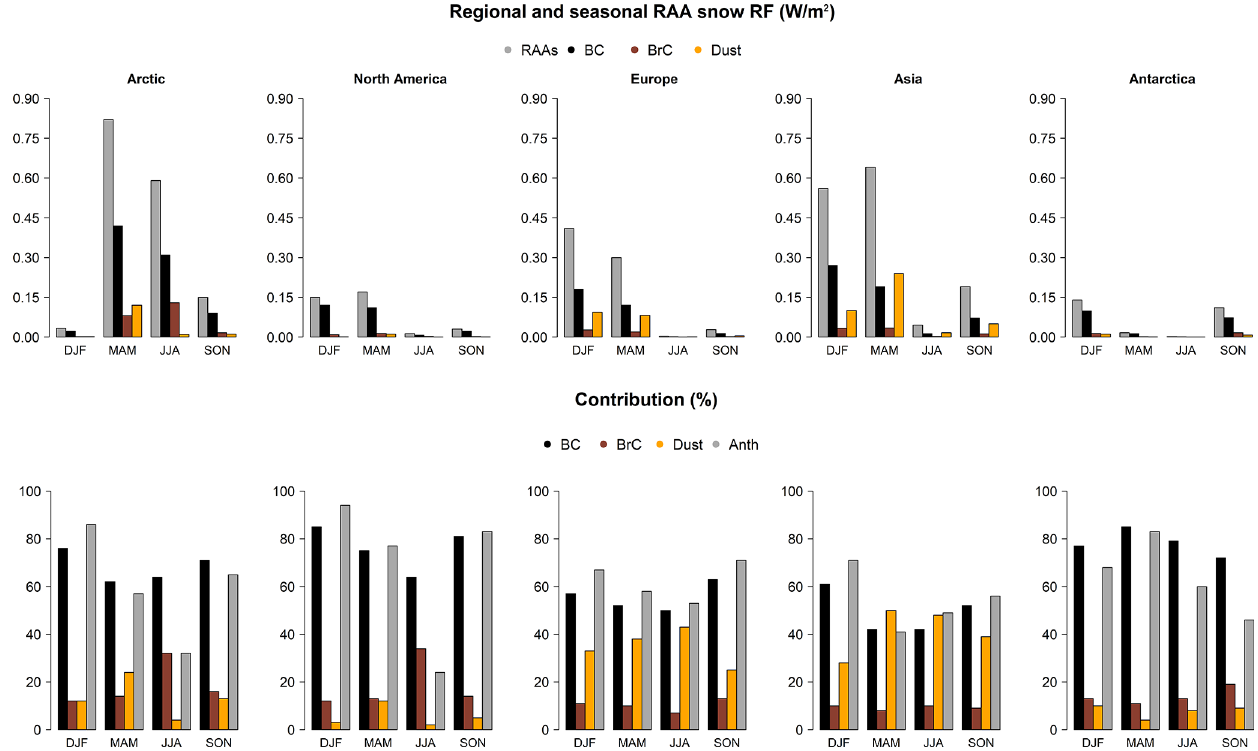
Figure 5. Top panel: all-sky regional and seasonal averages (2010–2014) of total RAA-, black carbon (BC)-, brown carbon (BrC)-, and soil dust-snow radiative forcing (RF), calculated from the CTRL experiment in the Arctic, North America, Europe, Asia, and Antarctica. Bottom panel: contribution of each single species and anthropogenic RAAs to total forcing. The anthropogenic contribution is given by BC and BrC from fossil fuel (FF) and biofuel (BF) sources and aromatic